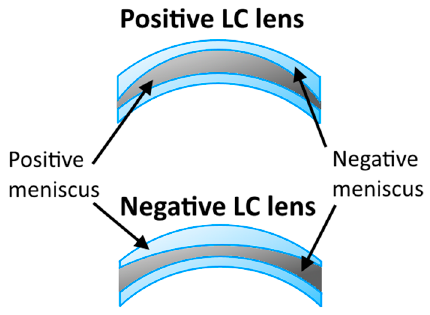
Figure 4. Illustration of lens design principles if one of the switching modes provides no change in focal power. The total focal power of the substrates must if negative if the LC layer has a positive meniscus ( top image ). Conversely, the substrates must have a positive focal power if the LC layer has a negative meniscus ( bottom image ).